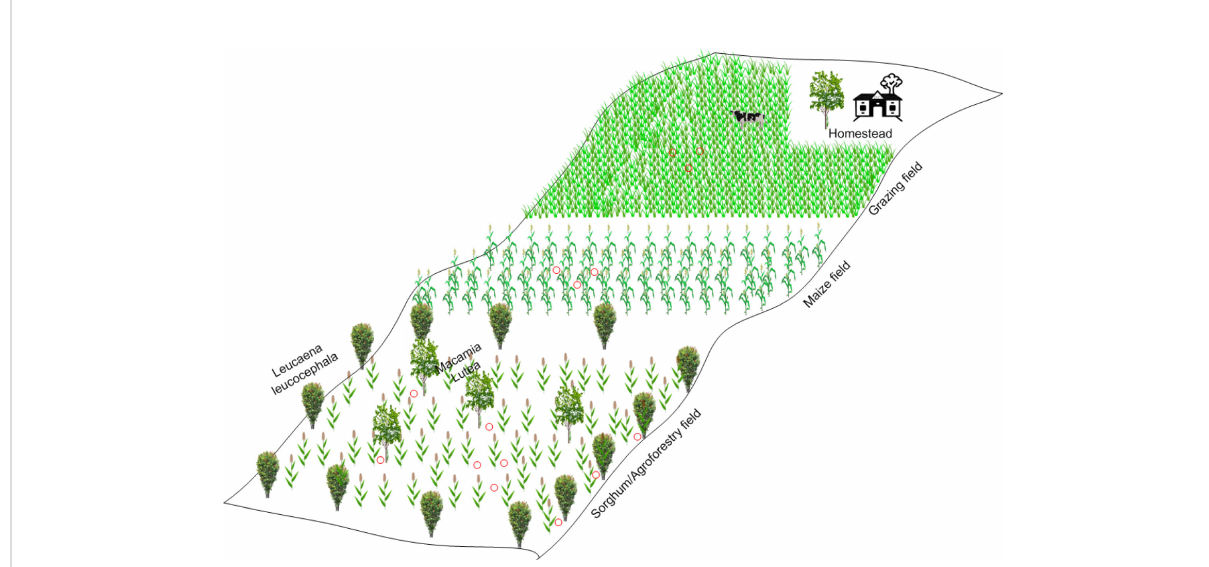
FIGURE 1 A sketch representation of the smallholder farm, the fi ve land utilization types, and chamber placement for gas sampling. The small red circles represent the static chambers (three replicates per LUT). The red circles are 3 m